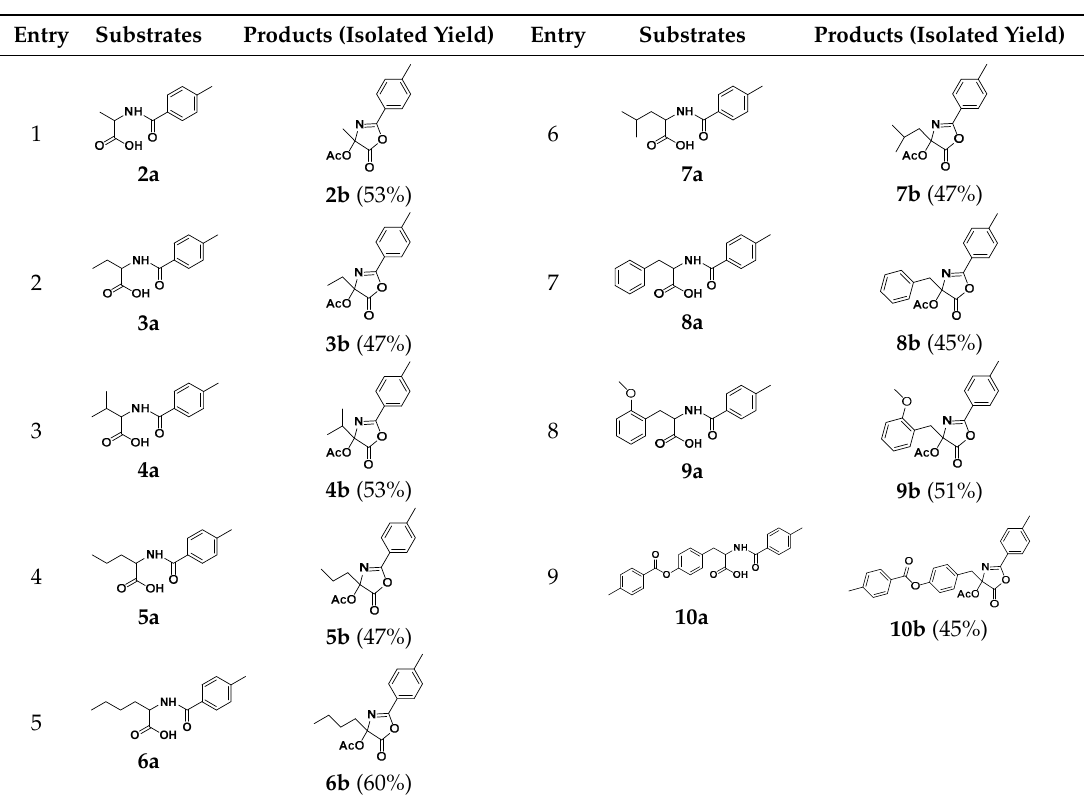
Table 2. Substrate scope of N- benzoyl amino-acids.